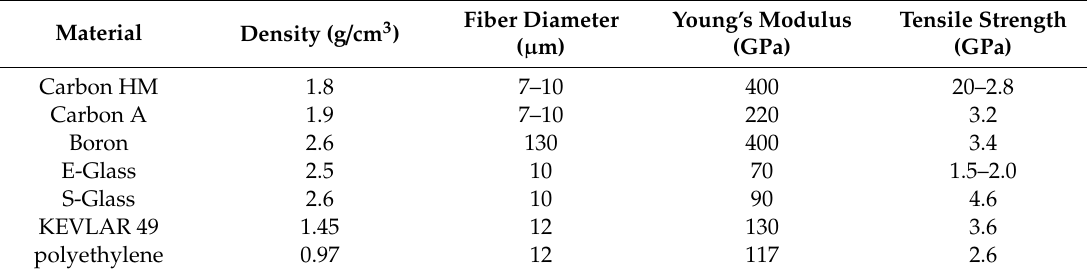
Table 1. Properties of reinforcing fibers